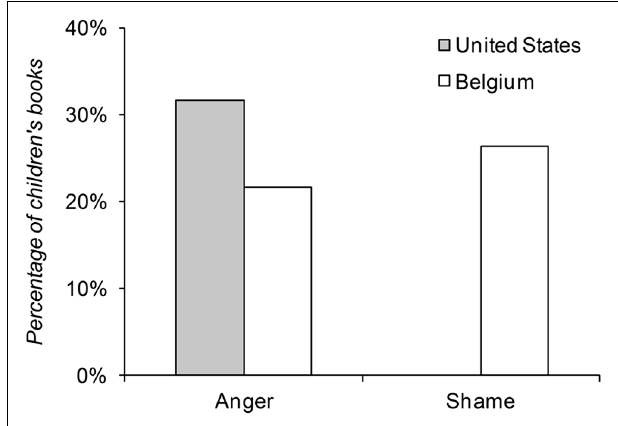
FIGURE 2 | Percentage of children’s books with anger or shame